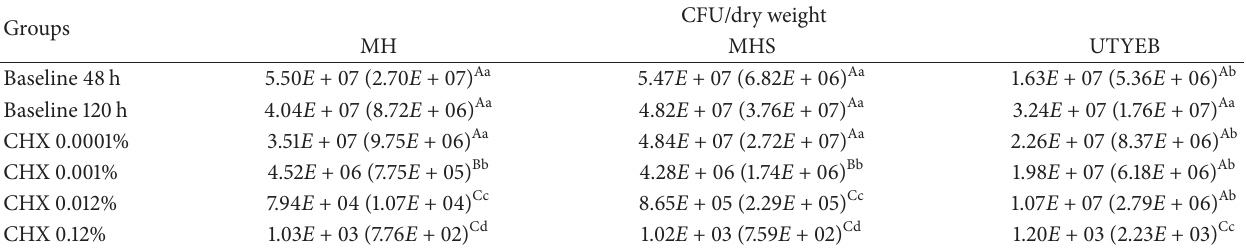
Table 3: % means and standard deviations of CFU/mg dry weight in the biofilms grown according to the treatments. Groups